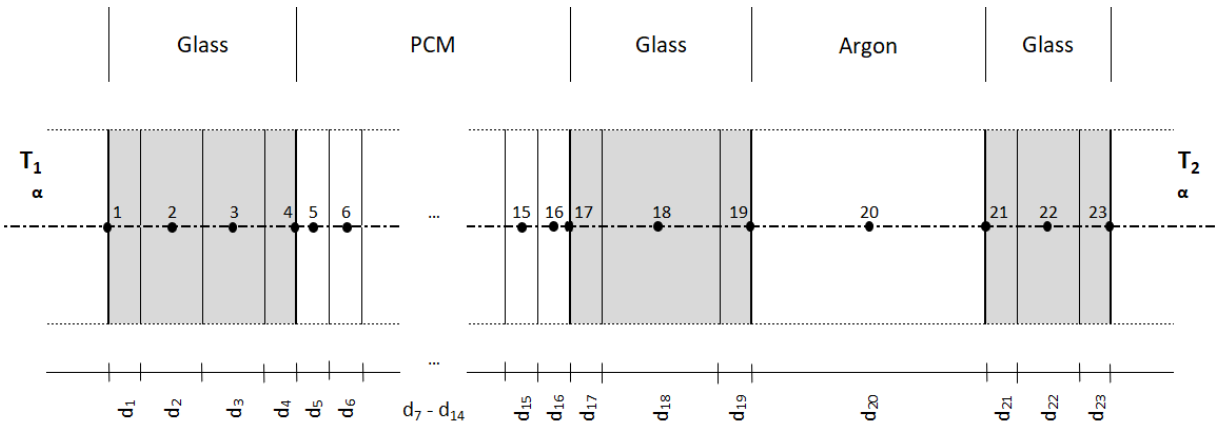
Figure 11. Domain discretization for the optimal number of control volumes representing phase change material.